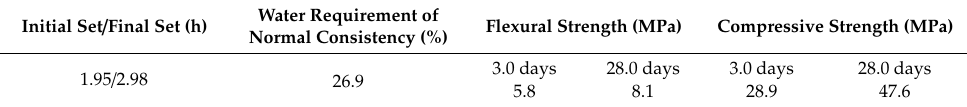
Table 1. Basic physical indexes of PO (ordinary Portland cement) 42.5 R cement.